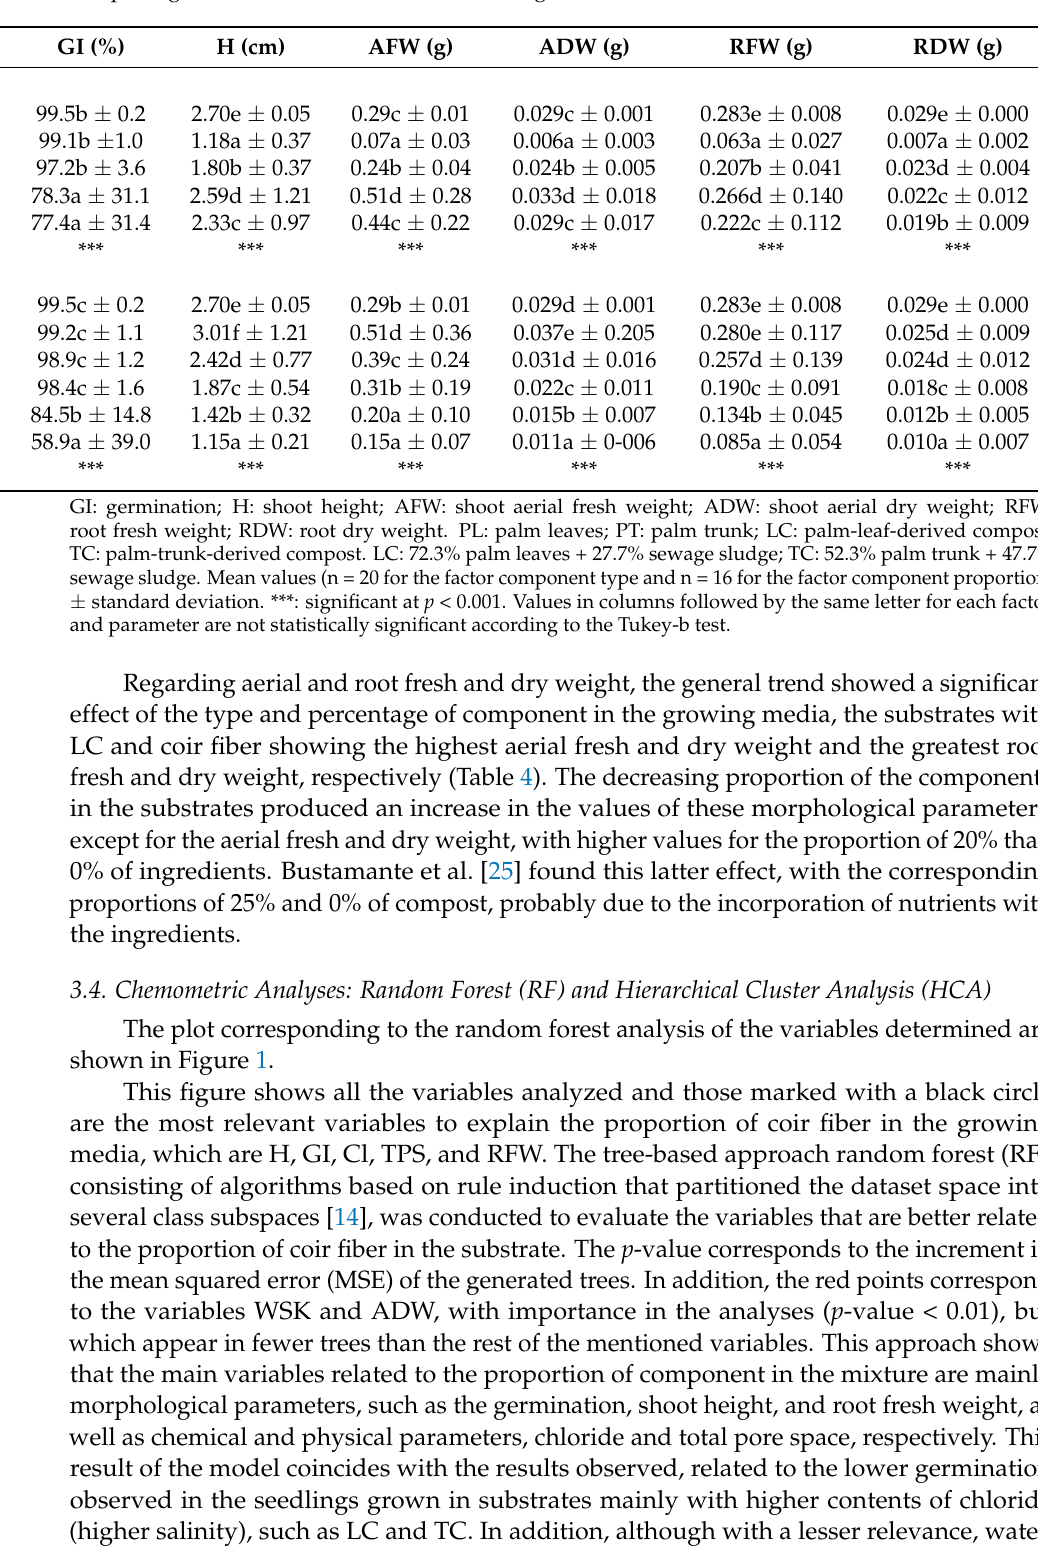
Table 4. Effect of the type and proportion of the organic materials considered in the germination and morphological characteristics of lettuce